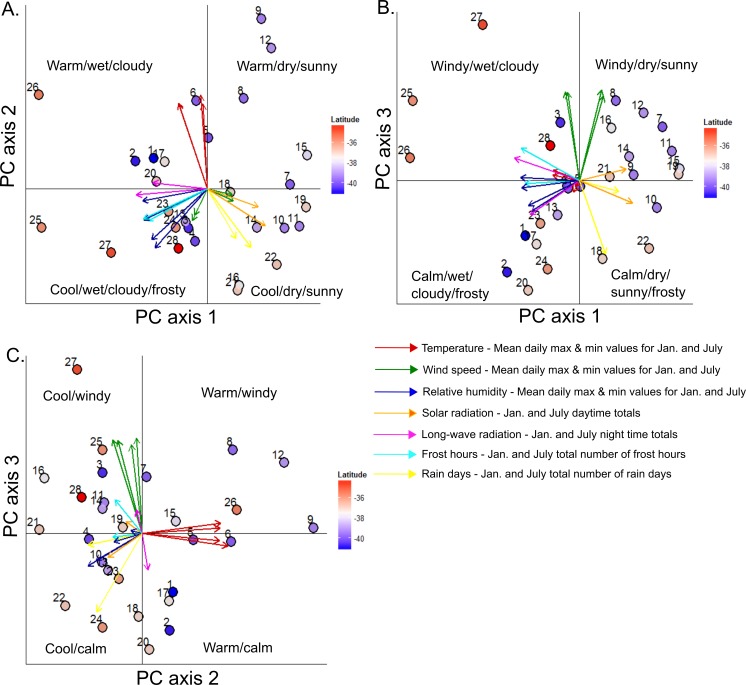
Bi-plots of a principal components analysis (PCA) of meterological data generated at southern beech treelines using the TAPM mesoscale atmospheric model. Bi-plots are shown for principal components 1 and 2 (A), 1 and 3 (B), and 2 and 3 (C), which collectively explain 80.2% of the variation in the data.PCA eigenvectors are coloured according to the type of meteorological variable; multiple vectors of the same colour occur when both maximum and minimum conditions for that variable, for both January and July, are included. Dots represent positions of the 28 study areas in ordination space, labelled with the site numbers and coloured by their latitidinal position. See Table 1 for axis loadings for each variable.